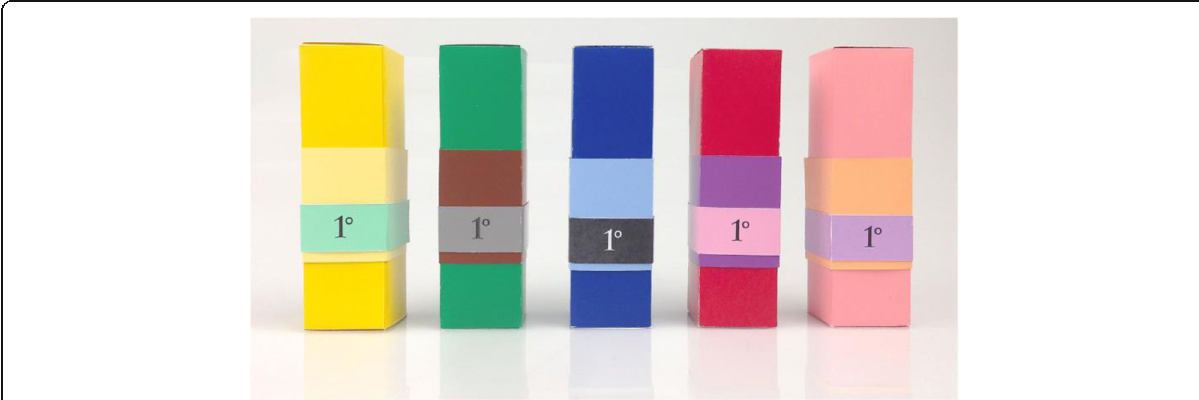
Fig. 1 The five prototype packages designed (on the basis of colour-odour crossmodal correspondences) to match the five commercial fragrances in Schifferstein and Howell ’ s (2015) study. From left-to-right, packaging schemes designed to match DKNY, Miss Dior, Kouros, Wish, and Paris, respectively. (see online version for colour